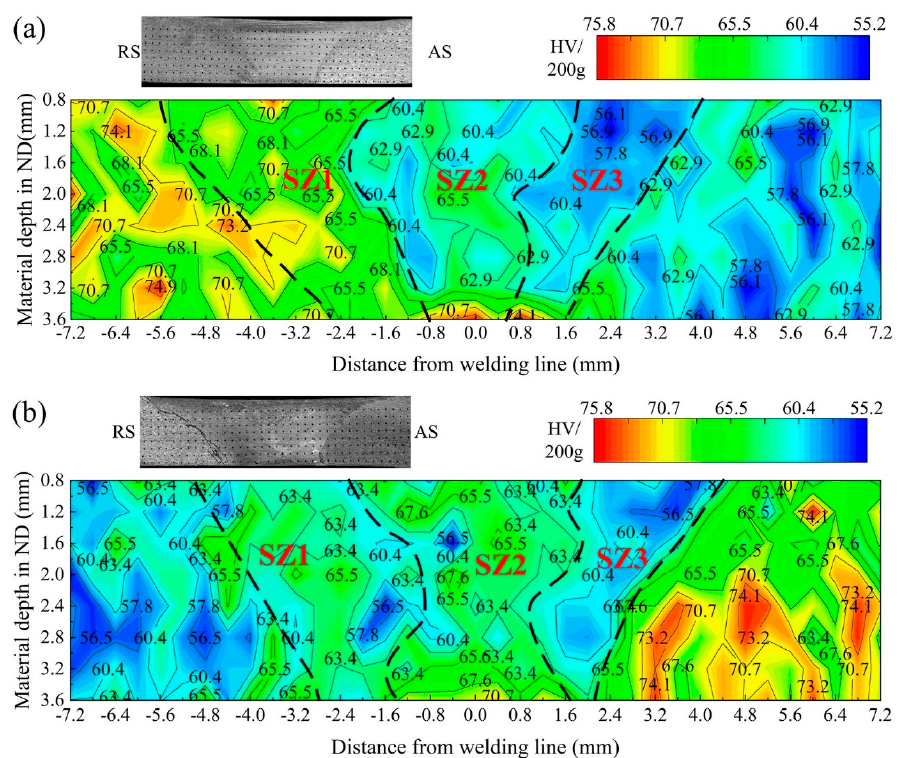
Figure 11. Hardness profile at the cross-section of the two welded joints: ( a ) the ZK60/ATZ511 joint; ( b ) the ATZ511/ZK60 joint.